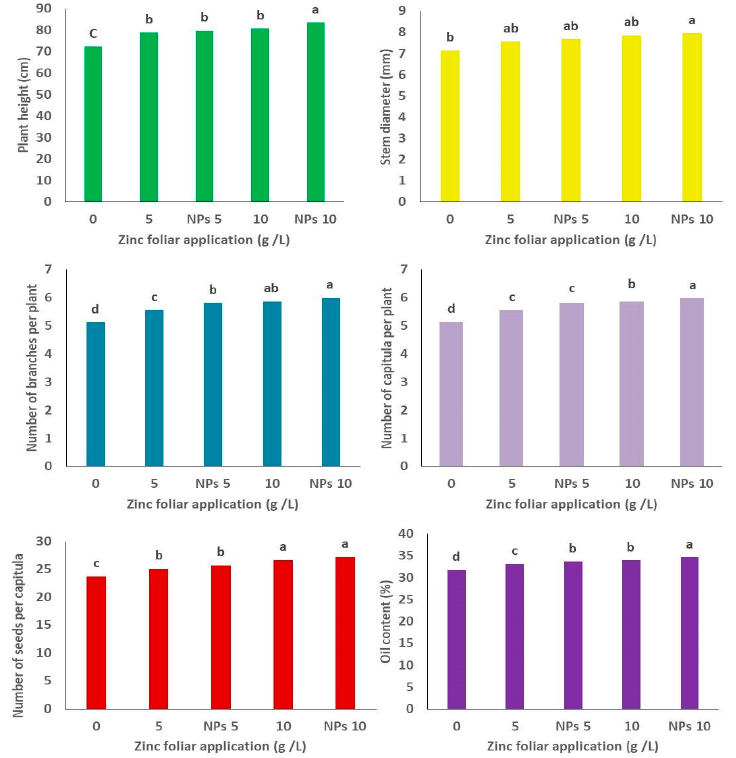
Figure 2. Main effects of zinc application on safflower traits. Different letters within each variable